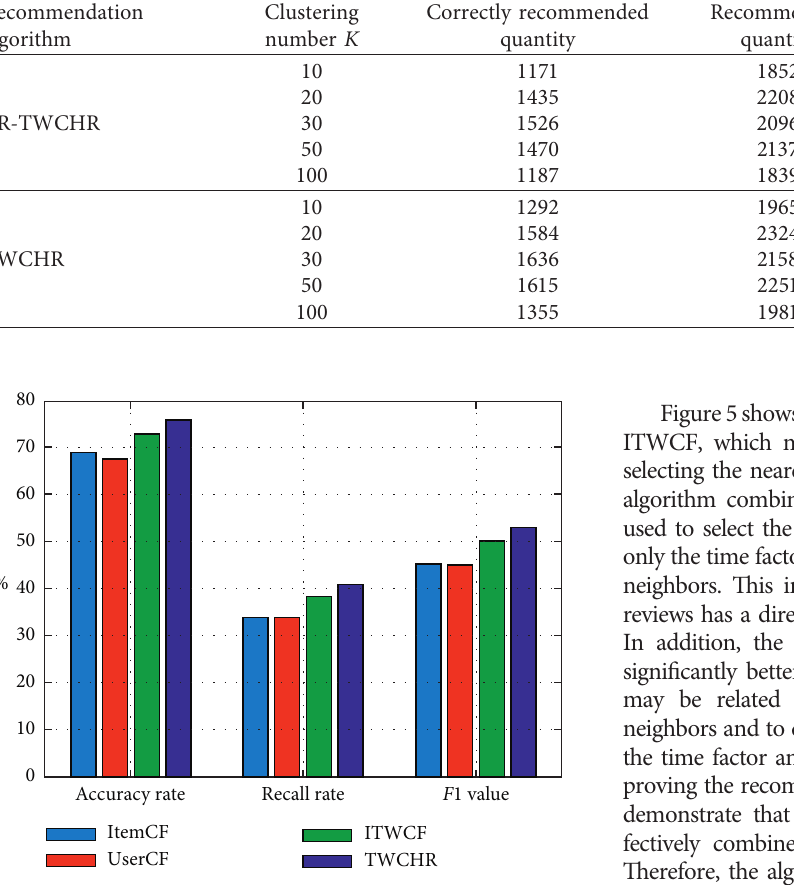
Table 2: The influence of sentiment analysis on recommendation results under different clustering numbers. Recommendation algorithm